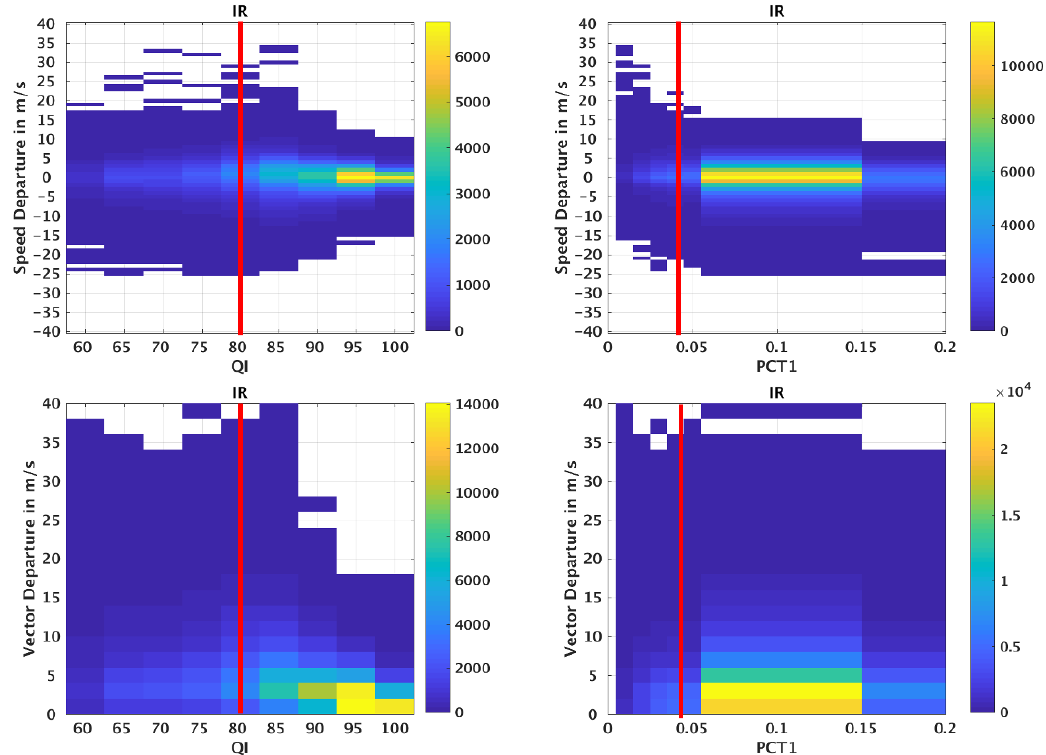
Figure 3. Density plots of QI (left) or PCT1(right) verses speed and vector departure (observation— first guess) for GOES-16 IR hourly AMV type. The red line indicates the threshold cutoff used currently.